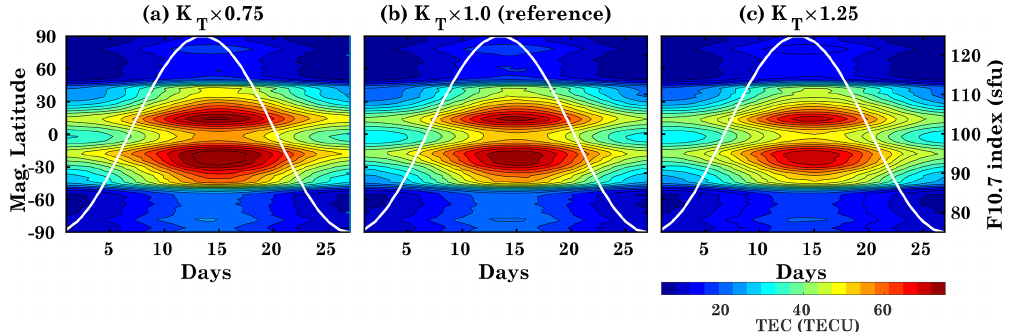
Figure 2. CTIPe-simulated daily mean zonal mean TEC for the runs (a) K T × 0 . 75, (b) K T × 1 . 0 (reference), and (c) K T × 1 . 25. The white curves show the F10.7 index